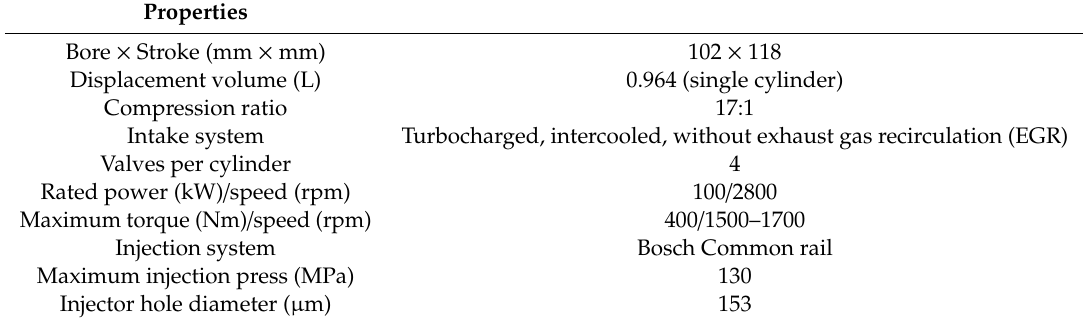
Table 1. Engine specifications.